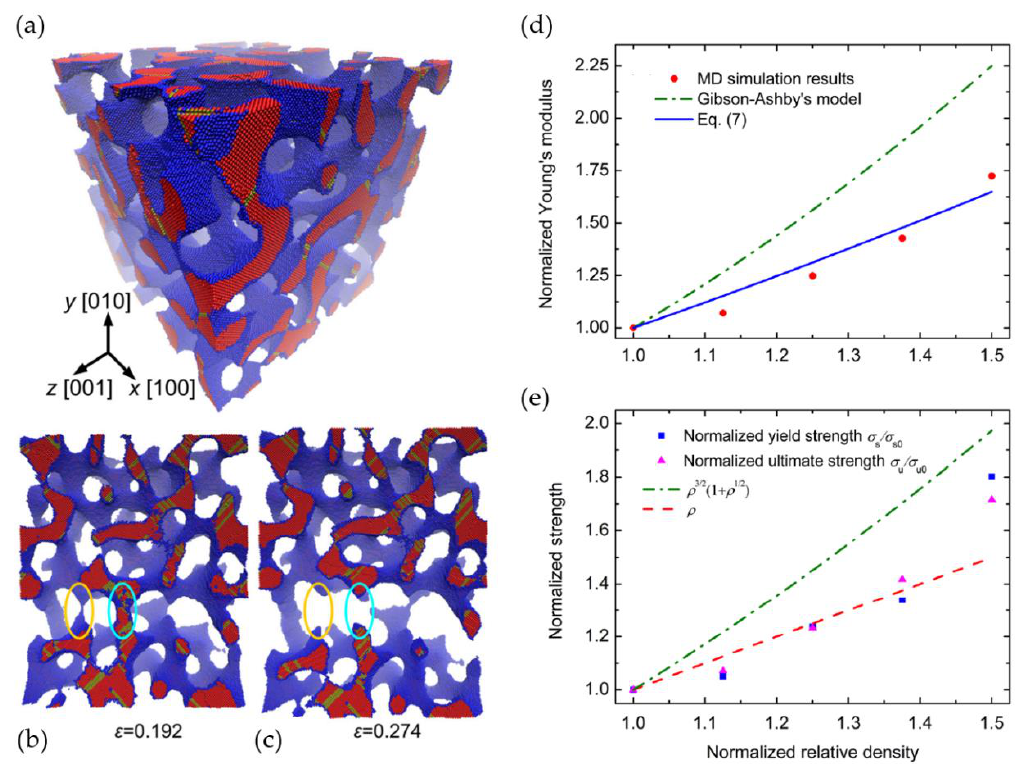
Figure 14. ( a – c ) Deformation behavior of np-Au under tension showing pinching-off of ligaments; ( d ) and ( e ) Comparison of simulation results with the Gibson–Ashby scaling laws and a modified version with a second term accounting for tension along the ligament axis. Reprinted from [117] with permission from Elsevier.